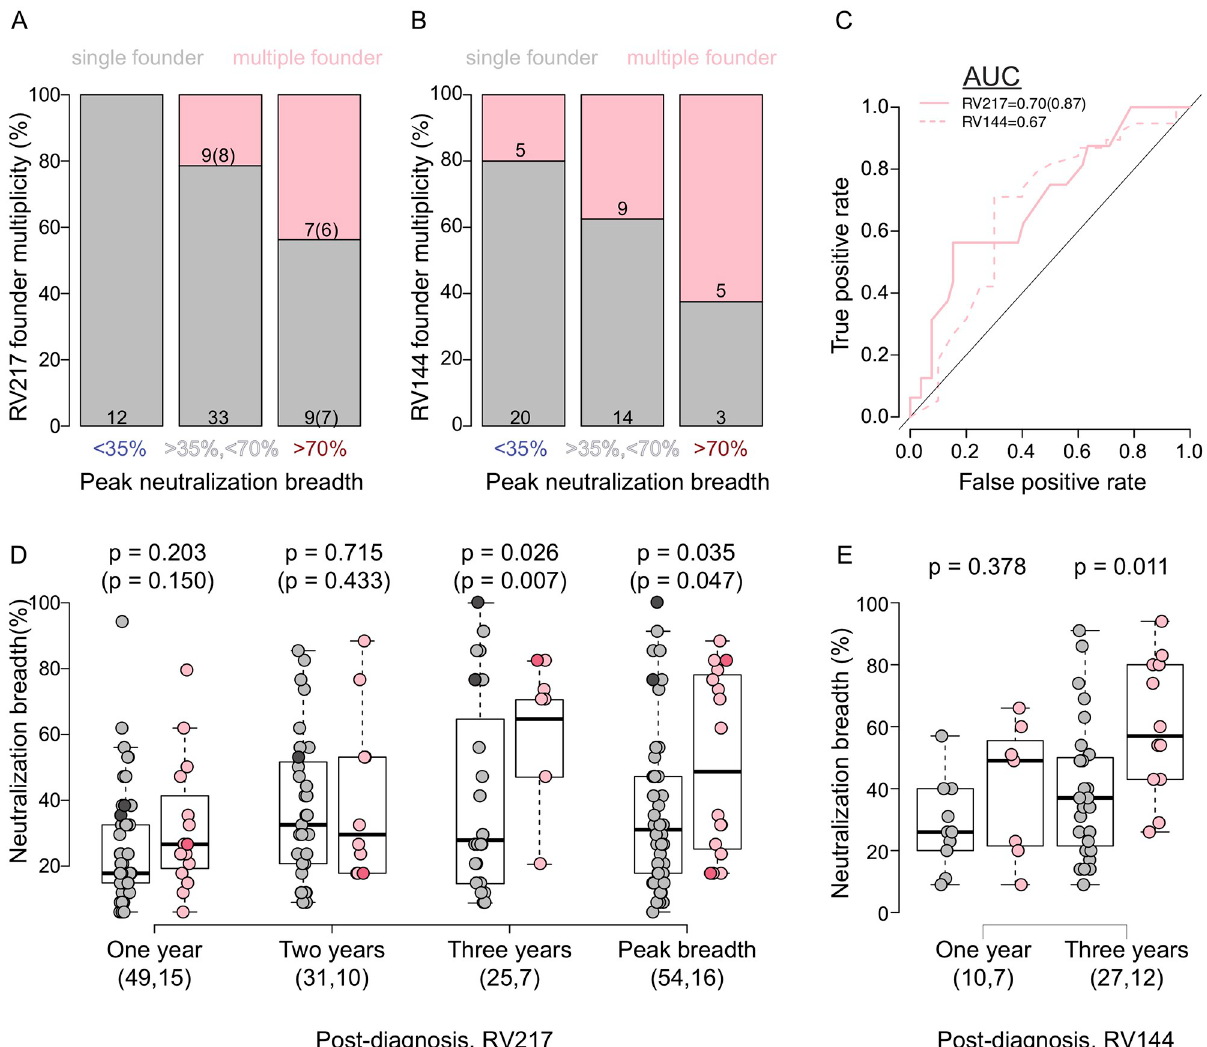
Fig 2. Association between infections with multiple founders and neutralization breadth. Comparisons of individuals who neutralized < 35% of a 34-virus panel three to four years post-infection (non-broad neutralizers) and > 70% of the panel (broad neutralizers) and had single (grey fill) or multiple (pink fill) founder infections. Individuals with neutralization estimates sampled less than two years post-infection are categorized as intermediate neutralizers (35% < neutralization breadth < 70%). Percentage of (A) RV217 participants and (B) RV144 placebo recipients within each breadth category who had infections with single (grey) and multiple (pink) founders. (C) ROC graph of the performance of founder multiplicity (pink line) for predicting neutralization breadth in RV217 participants (solid pink line) and RV144 placebo recipients (dashed pink line). The null expectation is shown as a solid black line. AUC estimates are shown. (D) Neutralization breadth in RV217 participants with single (grey) or multiple (pink) founder infections sampled at one year, two years, and three years post-diagnosis, and at peak breadth. Participants with superinfections are shown in darker shades. (E) Neutralization breadth in RV144 placebo recipients sampled at one year and three years post-diagnosis. (D,E) The number of individuals in each group is shown in parenthesis and p-values for pairwise comparisons are shown above each pair. (A,C,D) Parenthetical numbers indicate values after removing individuals identified as